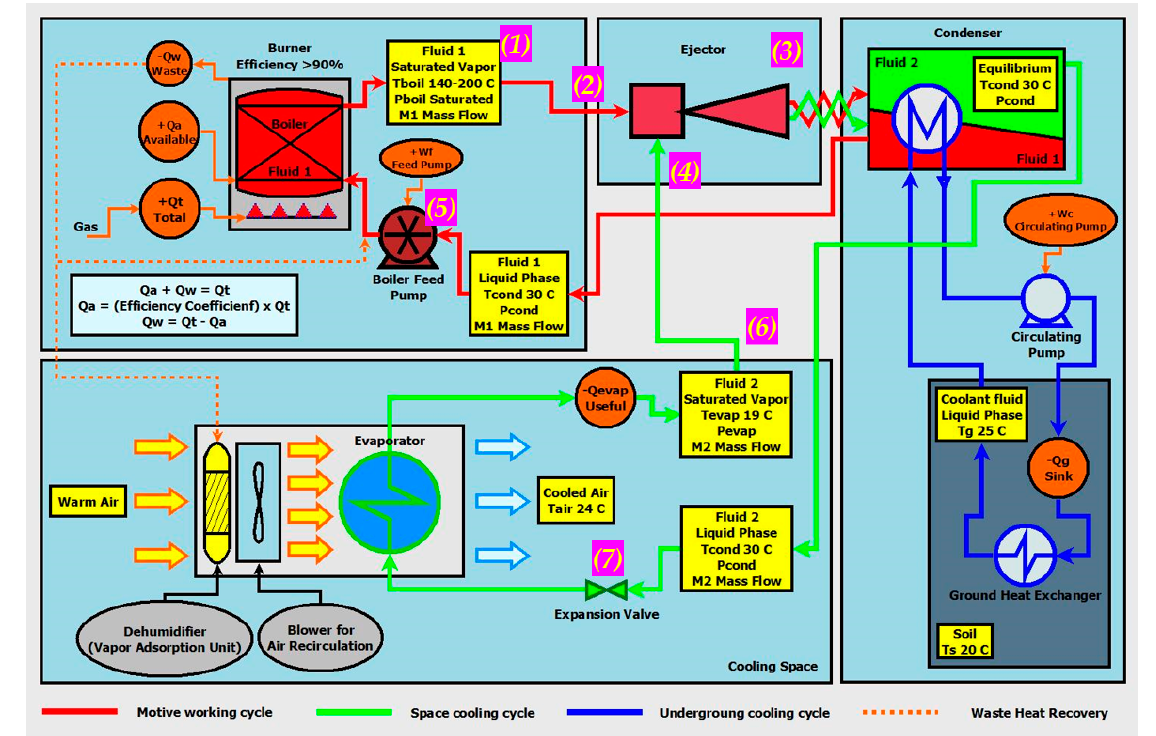
Figure 1. Schematic of BFE GSHP cooling system in block diagram